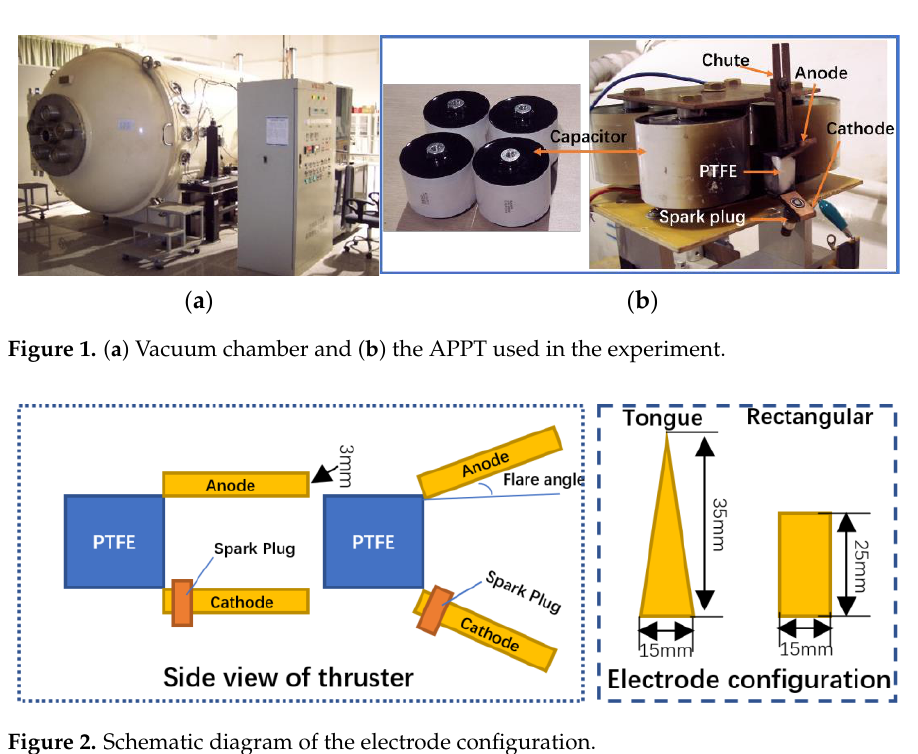
Figure 2. Schematic diagram of the electrode configuration.